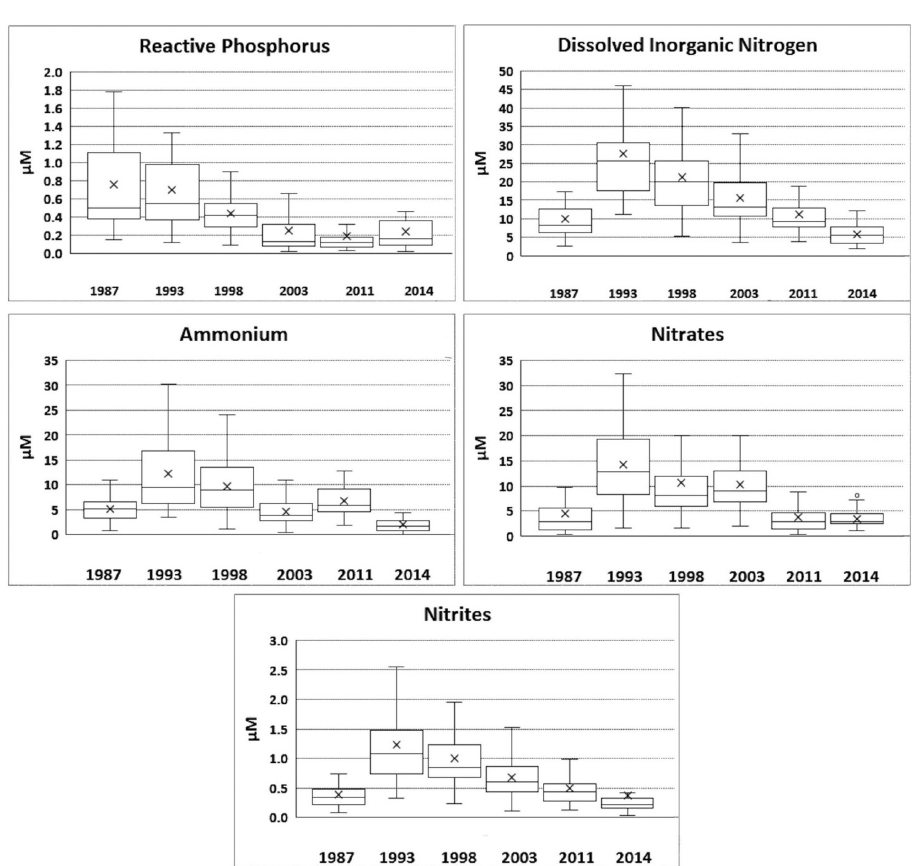
Figure 7. Trends of the mean, standard deviation, maximum, minimum and median values of the re- active phosphorus, dissolved inorganic nitrogen, ammonium, nitrate and nitrite concentrations in the central lagoon of